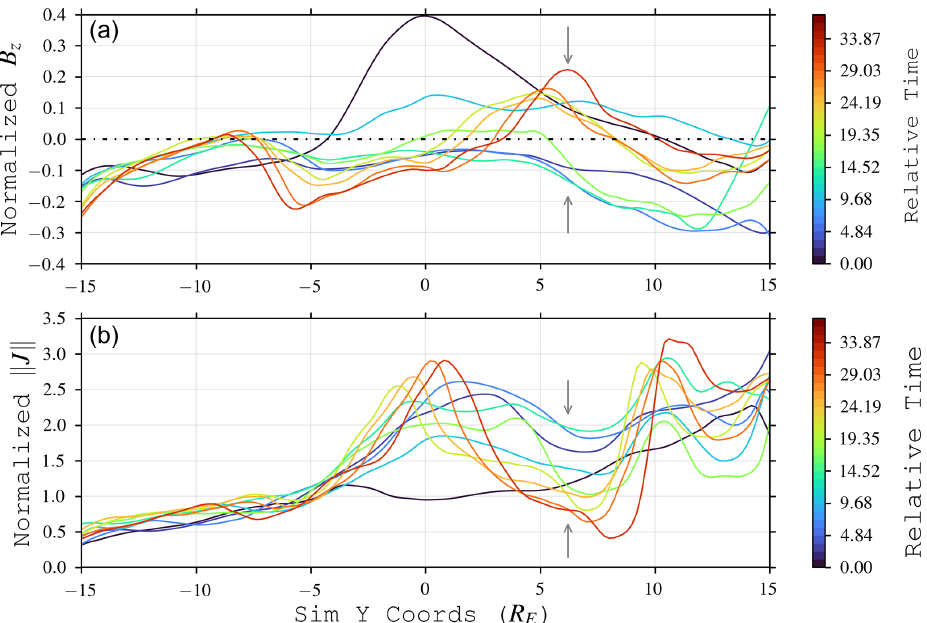
Figure 10. 1D cuts of tail magnetic field B z (a) and current density magnitude (cid:107) J (cid:107) (b) taken from x = 15 R E , − 15 R E <y < 15 R E in the z = 0 equatorial plane. (cid:107) J (cid:107) is normalized via J 0 = B w /L 0 ; B z is normalized via B w = 10 − 4 G. Colors denote times relative to t = 0 in Fig. 5 (top left panel). Arrows highlight where local pileup of B z on dawnside thickens the current sheet, resulting in a lower current density and impeding local